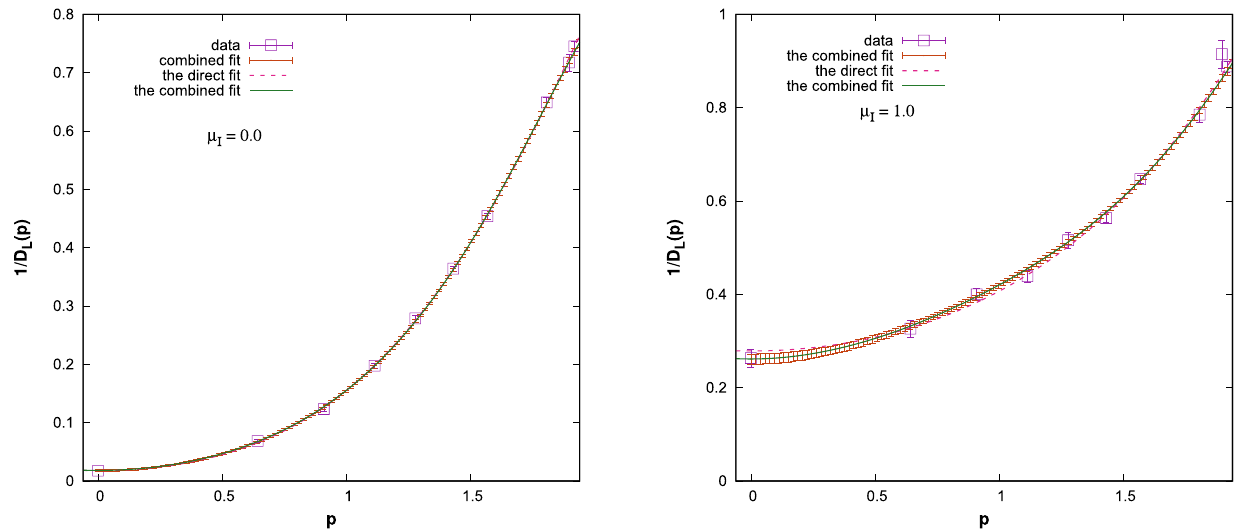
Fig. 1 The inverse longitudinal propagator interpolated by formula (20) (the combined fit) or by (15) (the direct fit) at μ I = 0 (left panel) and μ = 1 GeV (right panel). The corridors of errors in the former case are shown by the respective error bars. Data are shown by purple I